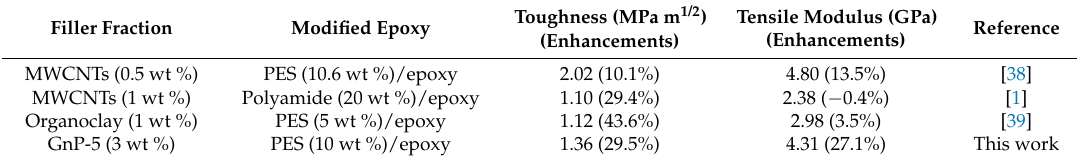
Figure 10. Fracture toughness of epoxy-based composites. Table 3. Comparison of other fillers for thermoplastic polymer modified